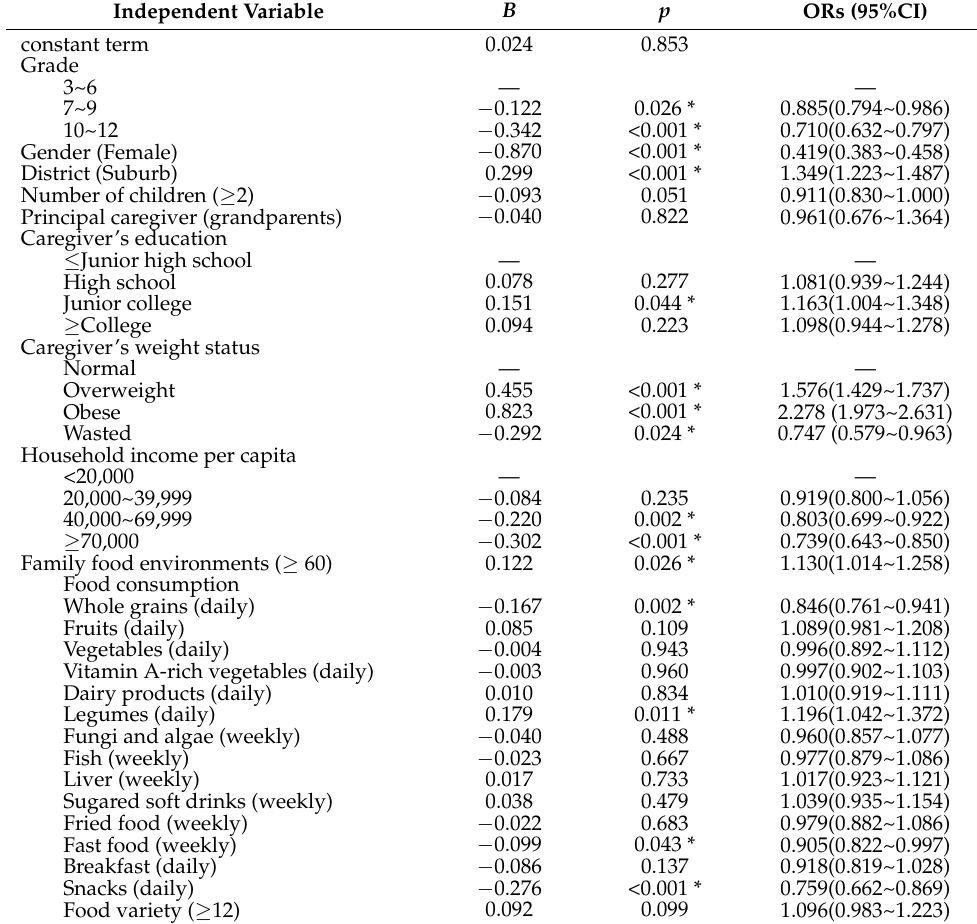
Table 7. Logistic regression analysis of students’ overweight